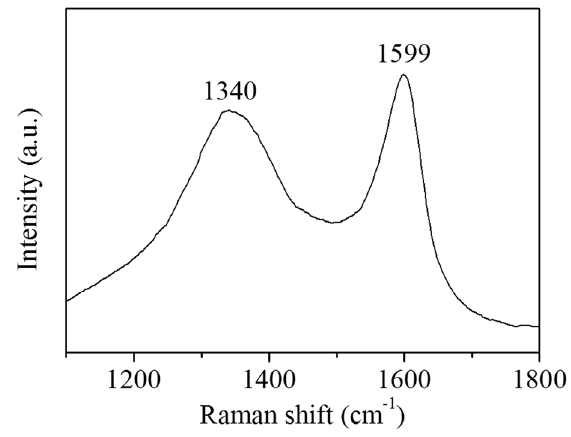
Figure 10. Raman spectrum of the spent 7% V/SBA catalyst after testing the dehydrogenation of isobutane with CO 2 at 570 °C for 250 min.